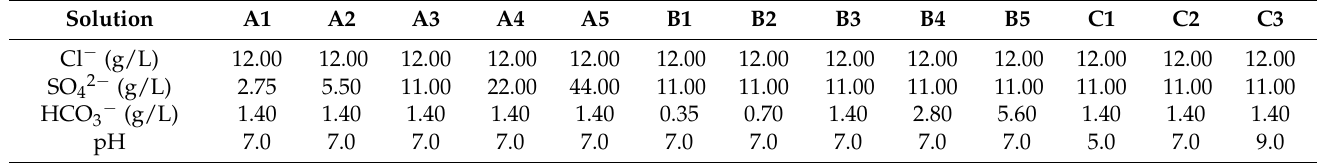
Table 1. The concentration of various ions in the simulated underground water